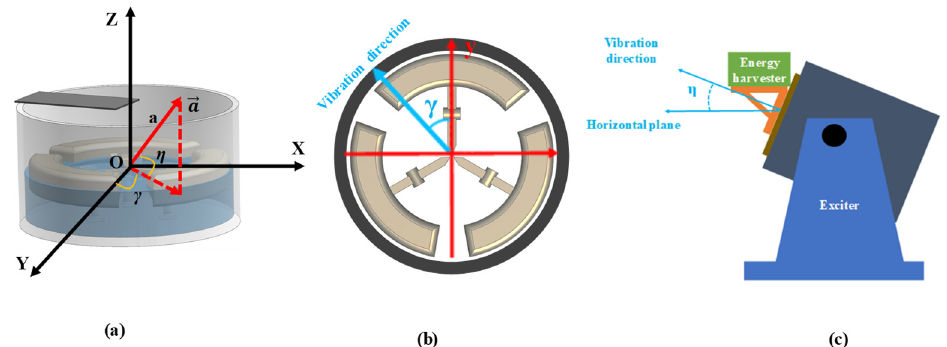
Figure 8. Excitation acceleration in ambient environment: ( a ) excitation acceleration in arbitrary directions; ( b ) acceleration in the horizontal plane; ( c ) acceleration in a vertical plane.